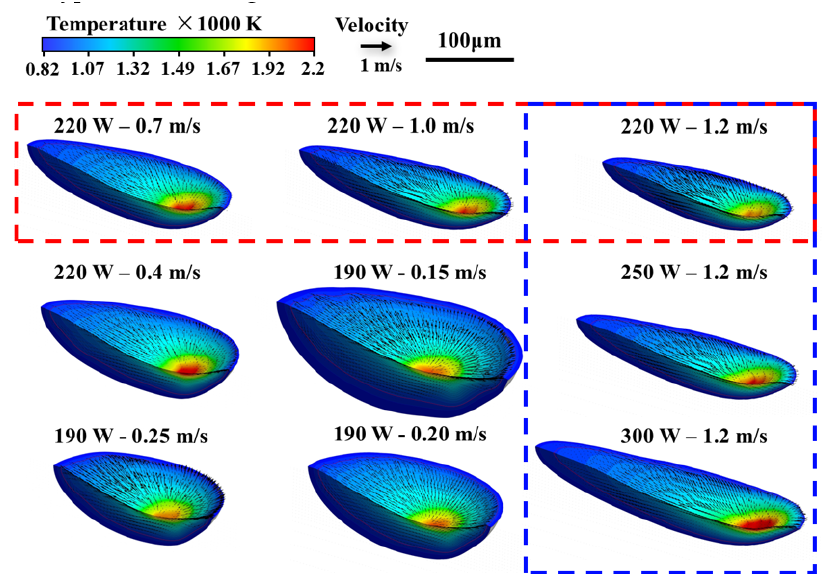
Figure 6. Temperature and velocity field of molten pool under different processing parameters.